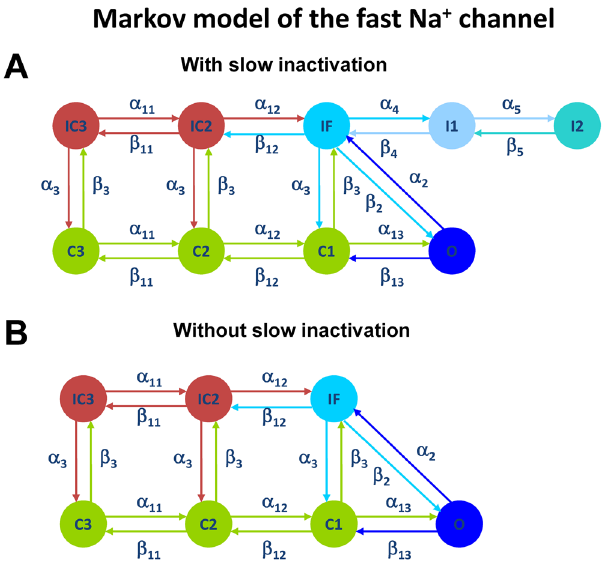
Figure 10. Markov models of the fast Na + current I Na with (Panel A) and without (Panel B) slow component of inactivation. Markov models contain three closed states (C1–C3), one open state (O), two closed-inactivated states (IC2 and IC3), one fast inactivated state (IF), and two slow inactivated states (I1 and